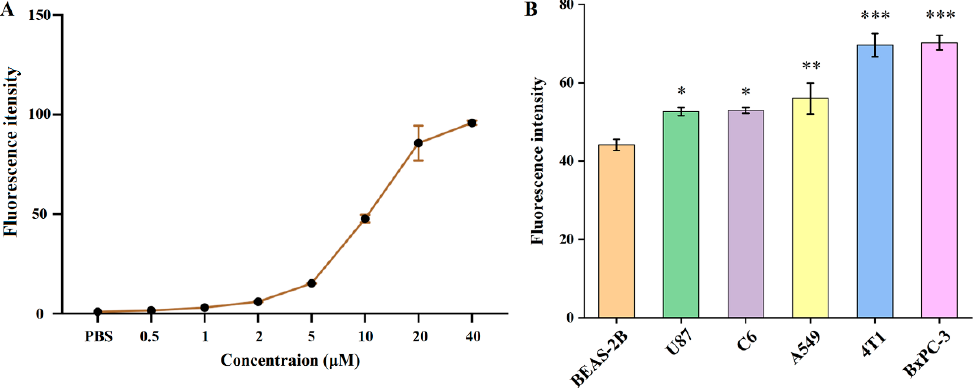
Figure 2. ( A ) Fluorescence intensities of C6 cells treated with FITC-PTP at different concentrations (0 to 40 µM) for 4 h, and ( B ) fluorescence intensities in six types of cells treated with FITC-PTP at 10 µM for 4 h. (*) for p < 0.5, (**) for p < 0.01, (***) for p < 0.001.